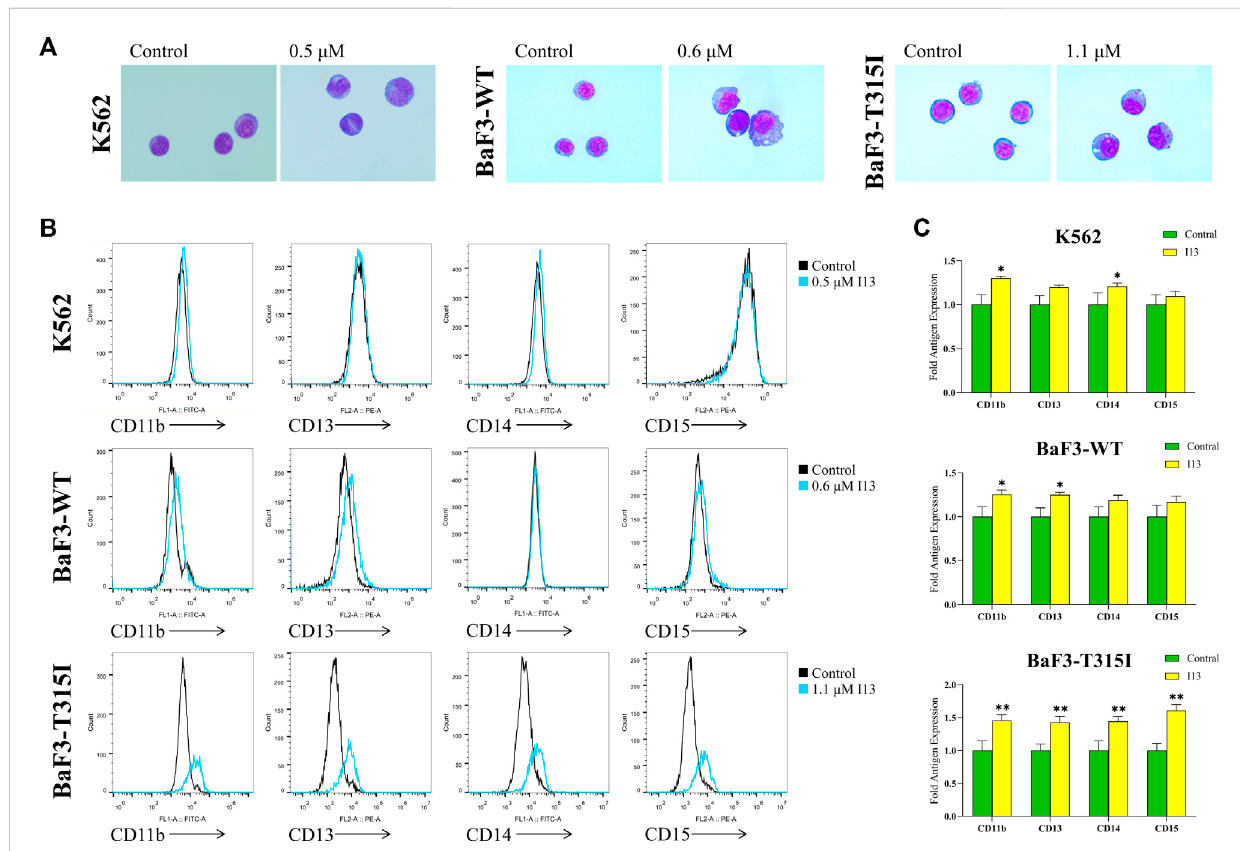
FIGURE 4 I13 promoted the differentiation of K562, BaF3-WT, and BaF3-T315I cells characterized by the change of morphology and cell surface markers. (A) Morphological changes of cells stained with the Wright – Giemsa dye solution and examined with light microscopy (×1,000). (B) Cell surface antigen expression was detected by fl ow cytometry. (C) The mean intensity of fl uorescence is shown in a bar graph. The BaF3-T315I, K562, and BaF3-WT cells were stimulated with 1.1, 0.5, or 0.6 µM of I13, respectively, for 72 h (* p < 0.05, ** p <